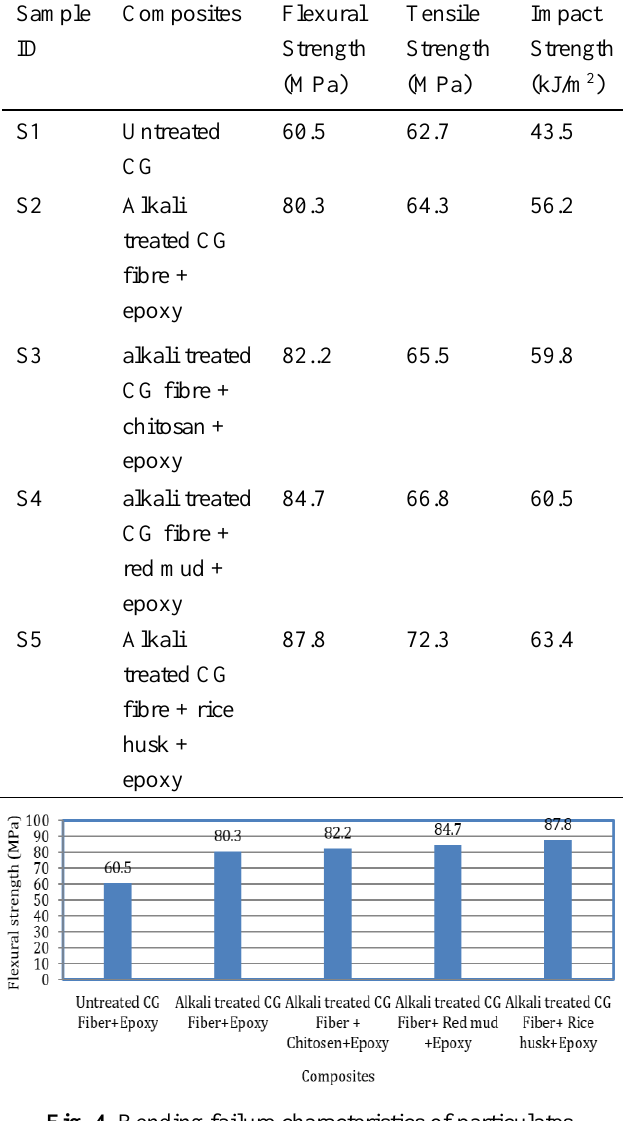
Fig. 4. Bending failure characteristics of particulates impregnated CG-Epoxy